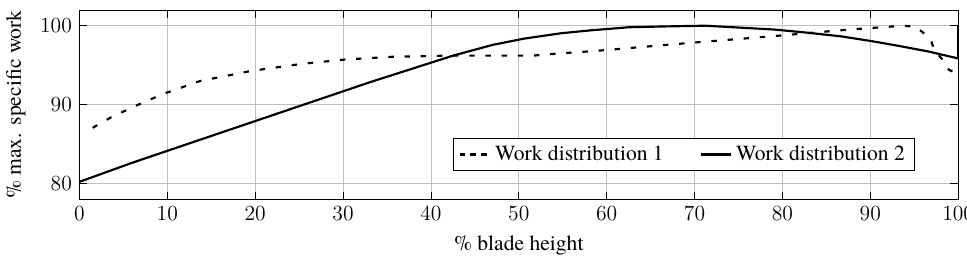
Figure 5. Fan blade work distributions according to